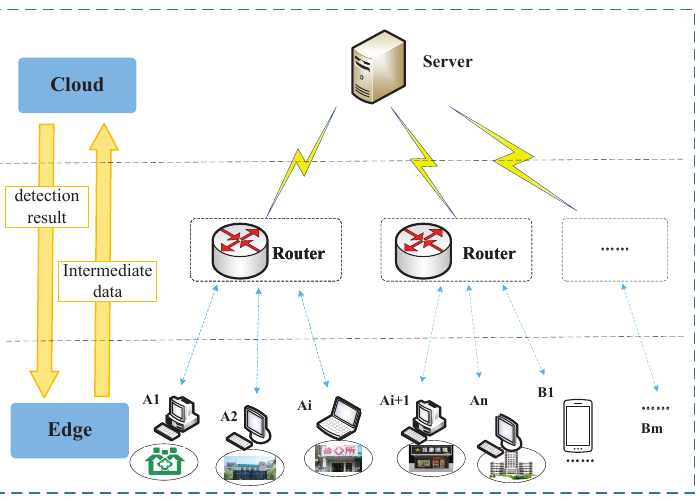
Figure 4. Remote ROP diagnosis system architecture based on cloud–edge